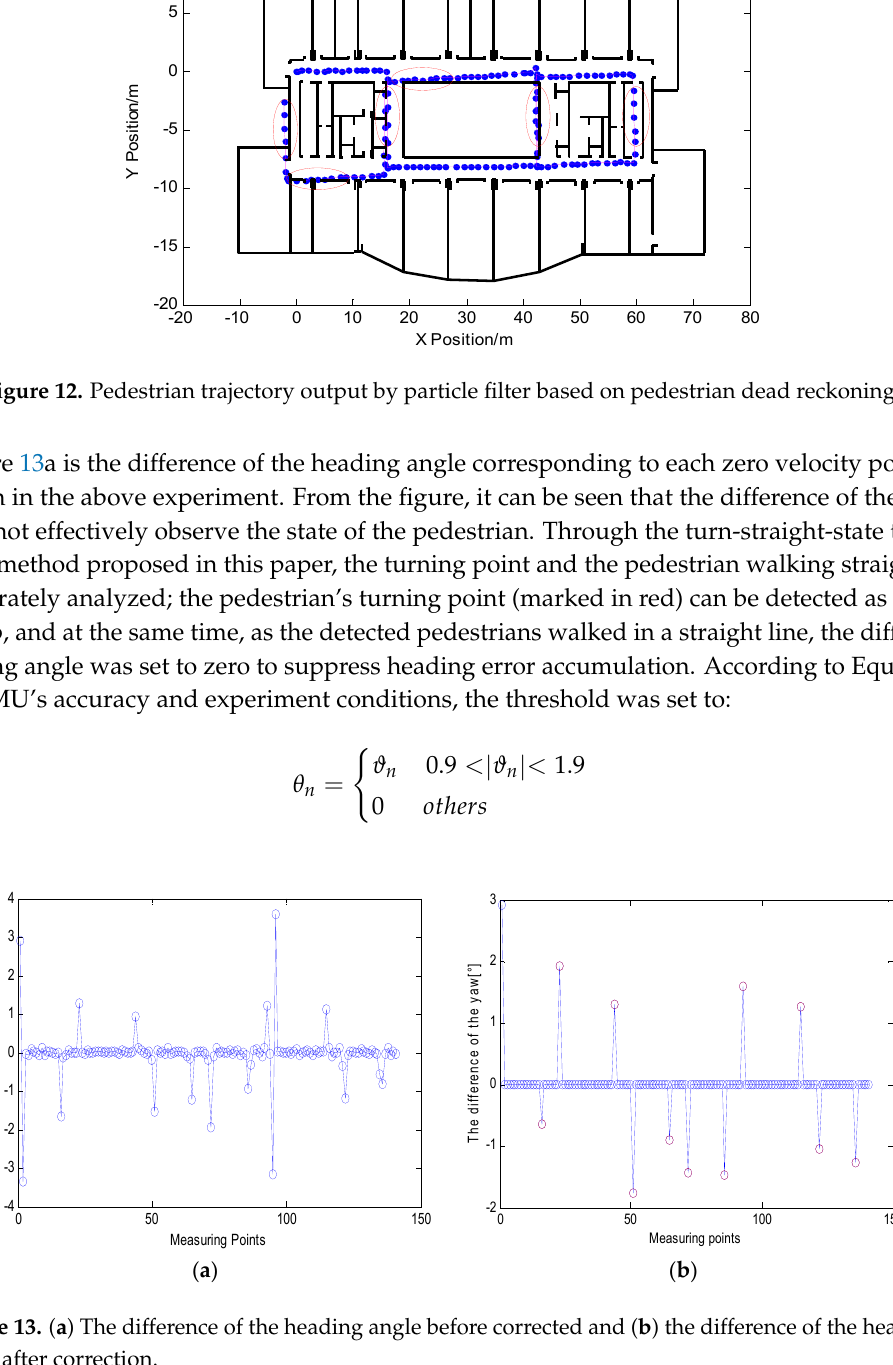
Figure 13. ( a ) The difference of the heading angle before corrected and ( b ) the difference of the heading angle after correction.